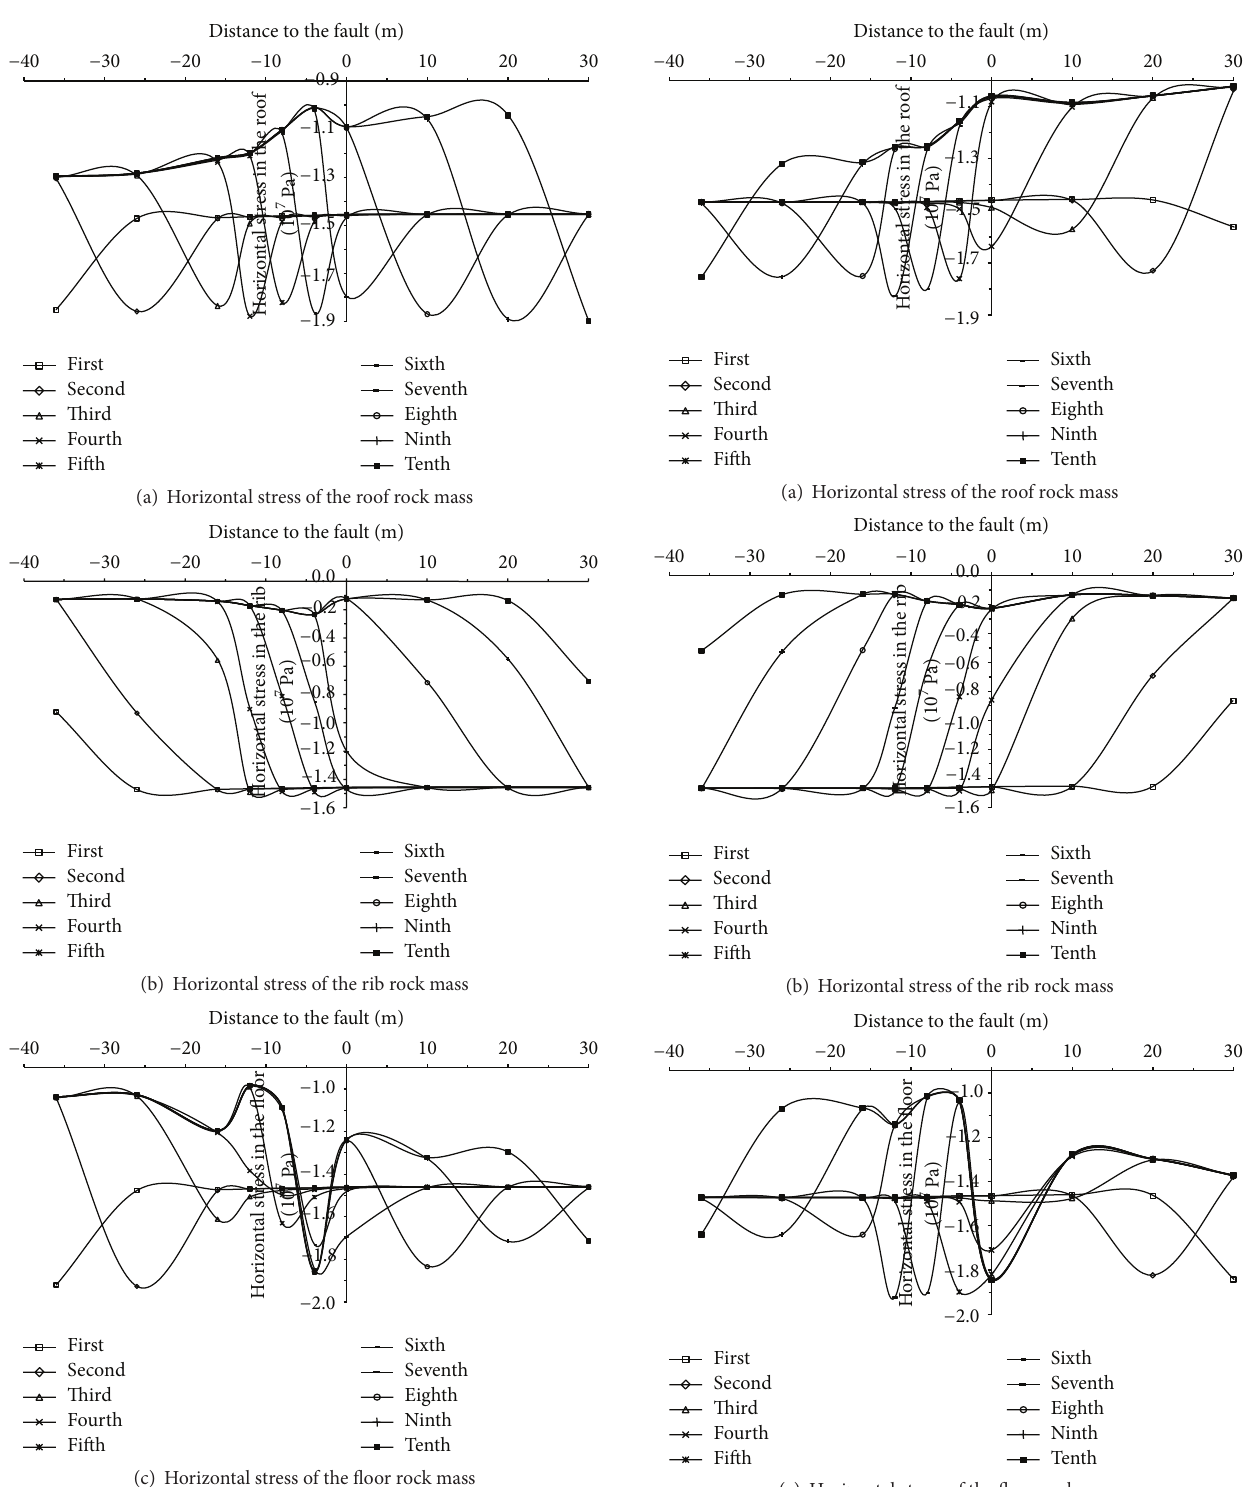
Figure 11: Horizontal stress of the surrounding rocks when the roadway passes from the hanging wall to the foot wall of the fault. Note: first to tenth denotes the excavation sequence.